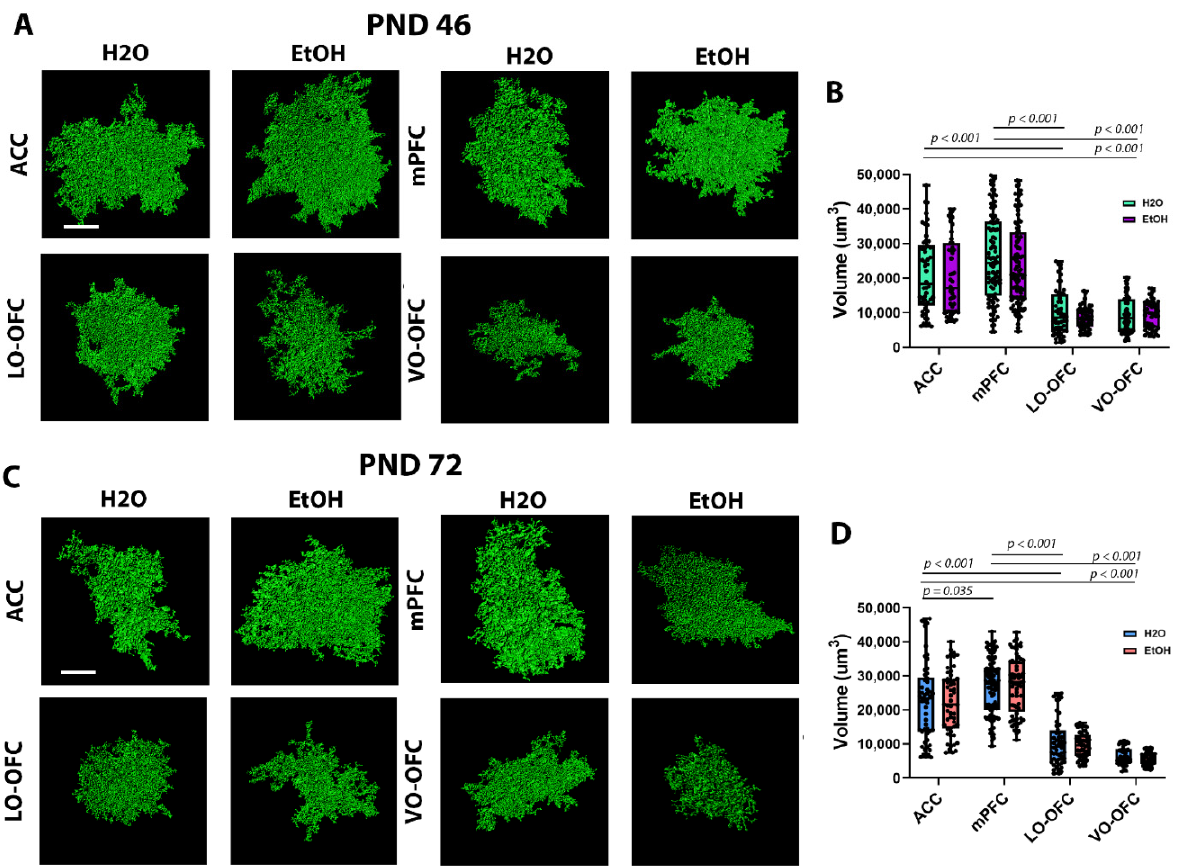
Figure 2. Single cell imaging and analysis of astrocyte volumes 24 h after AIE during withdrawal and 26-days after AIE. ( A ) Representative images of astrocyte surface rendering from the ACC, mPFC, LO-OFC, and VO-OFC 24 h after the final dose of EtOH. Scale bar, 20 µ m. ( B ) Quantification of astrocyte volumes 24 h after the final dose of EtOH. When comparing astrocyte volume across subregions within the control groups, there was a significant decrease in astrocyte volume in LO-OFC and VO-OFC when compared to ACC and mPFC. There was no significant treatment effect (H 2 O vs. EtOH) within subregions. ( C ) Representative images of astrocyte surface rendering from the ACC, mPFC, LO-OFC, and VO-OFC following a 26-day forced abstinence period. Scale bar 20 µ m. ( D ) Quantification of astrocyte volumes following a 26 day-day forced abstinence period. When comparing control conditions across subregions, there was a significant decrease in astrocyte volume in LO-OFC and VO-OFC when compared to ACC and mPFC. There was no significant treatment effect (H 2 O vs. EtOH) within subregions ( p > 0.05). Error bars represent minimum and maximum values in each data set. Data presented as box and whisker plots with interquartile range with mean, minimum, and maximum measures indicated along with individual data points. Analysis: two-way ANOVA with Tukey’s post hoc comparison, n = 5/treatment group.